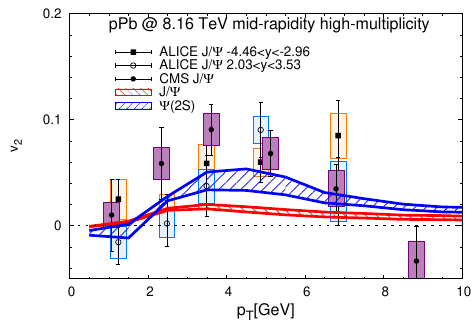
Figure 8 . Transverse-momentum dependent v 2 for J= (red band) and (2 S ) (blue band) at mid- rapidity in high-multiplicity p -Pb(8.16 TeV) collisions within the elliptic (cid:12)reball model, compared to ALICE and CMS data [22,